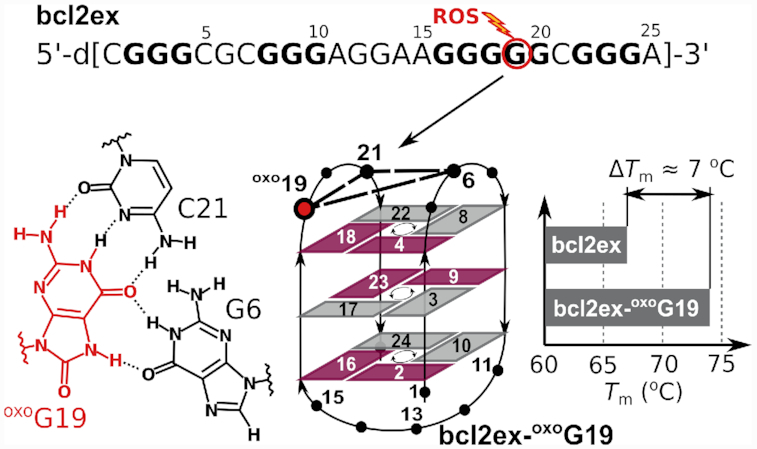

oxoG influences the fold of a G-quadruplex structure within the human BCL2 promoter and enhances the thermal stability of the G4 structure by forming novel structural elements.